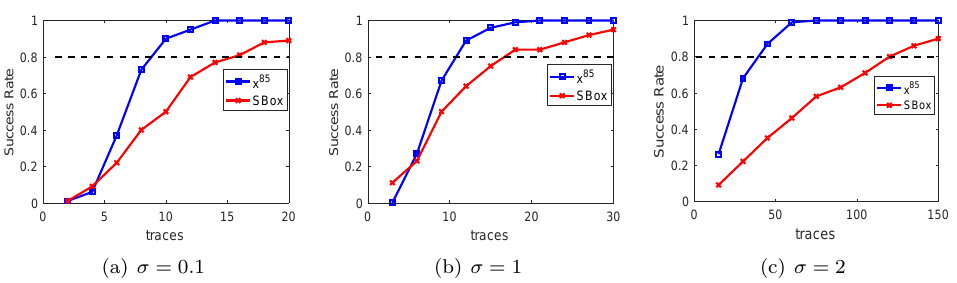
Figure 12: The success rate for ETA on simulated protected leakages with different noise levels.